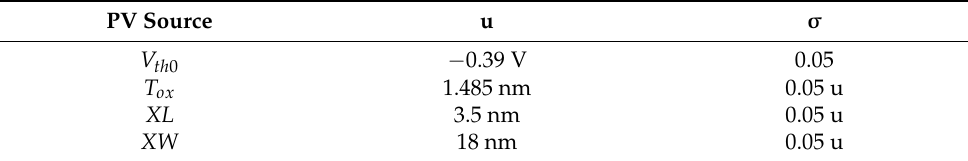
Table 1. Process parameters with nominal values and variation